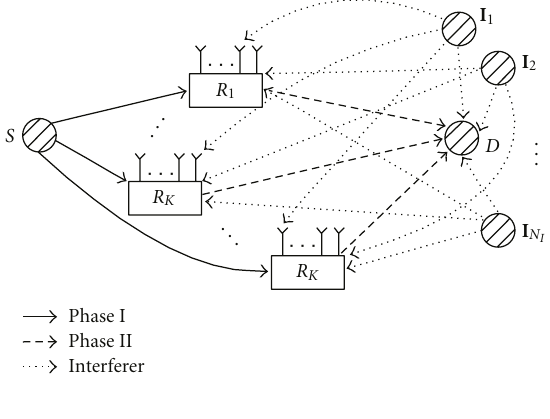
Figure 1: System